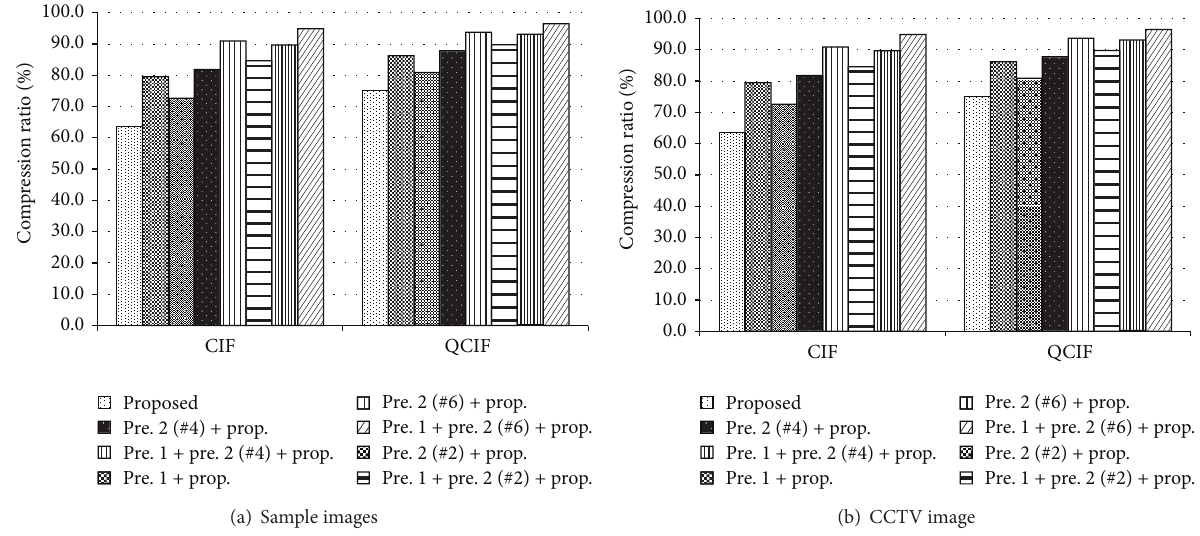
Figure 9: Compression ratio per frame with preprocessing techniques.